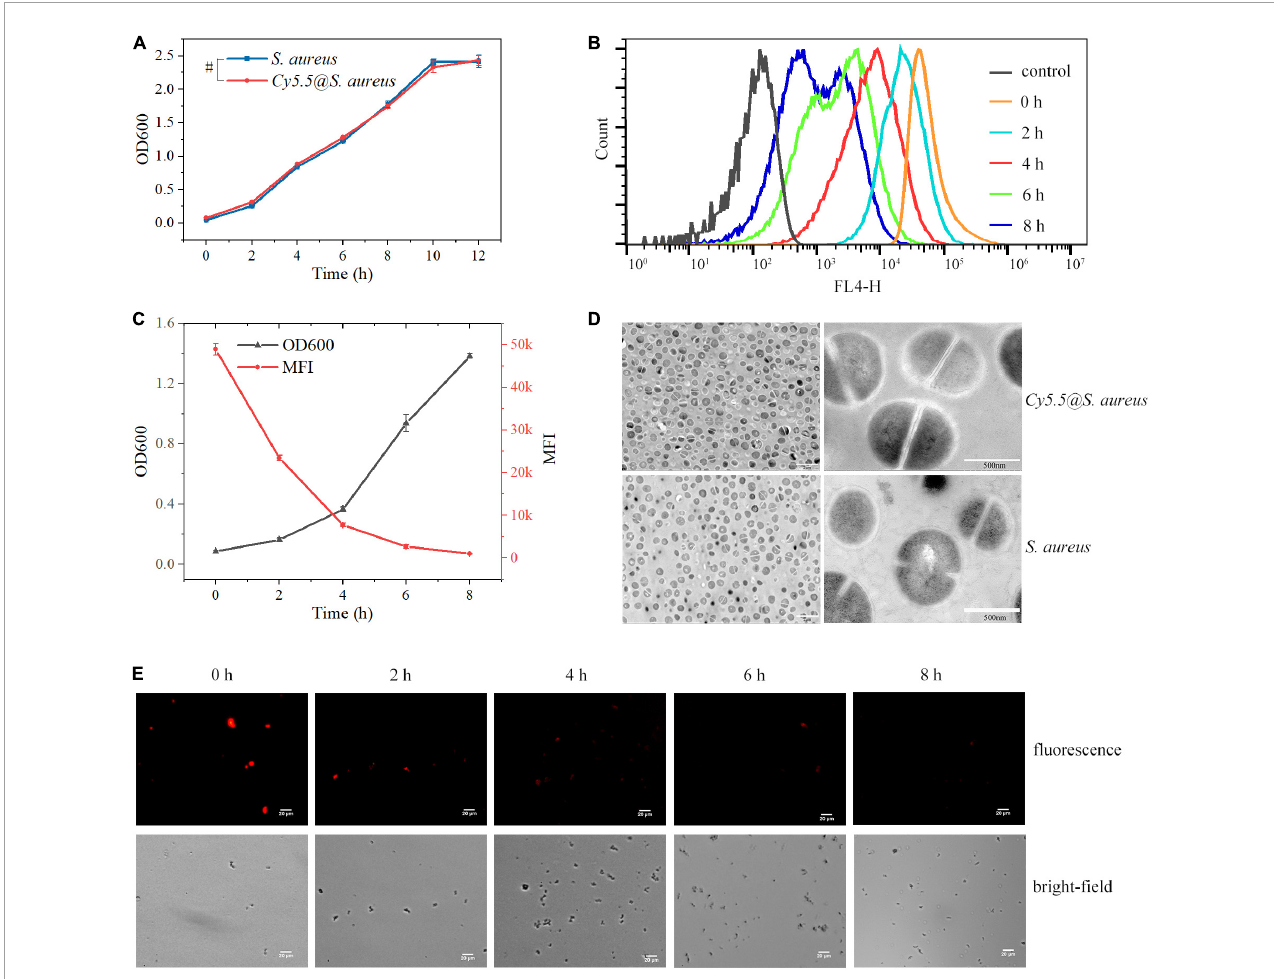
FIGURE5 (A) Cytotoxicity assay of Staphylococcus aureus following incubation with Cy5.5 at a concentration of 2 µ g/mL. Control refers to unlabeled S. aureus . (B) Quantitative analysis of fluorescence signal loss at various time points of Cy5.5@S. aureus re-culture by flow cytometry. Control refers to unlabeled S. aureus (FL4-H channel). (C) Double Y-axis plot of OD600 and fluorescence intensity of Cy5.5@S. aureus over incubation time. (D) TEM micrographs of Cy5.5@S. aureus and unlabeled S. aureus . (E) Fluorescence micrographs of Cy5.5@S. aureus cultured in NB at different time points, with Cy5.5@S. aureus shown in red (scale bar: 20 µ m, exposure time: 300 ms). Data are displayed as mean ± SD. # P > 0.05. N = 3 in each